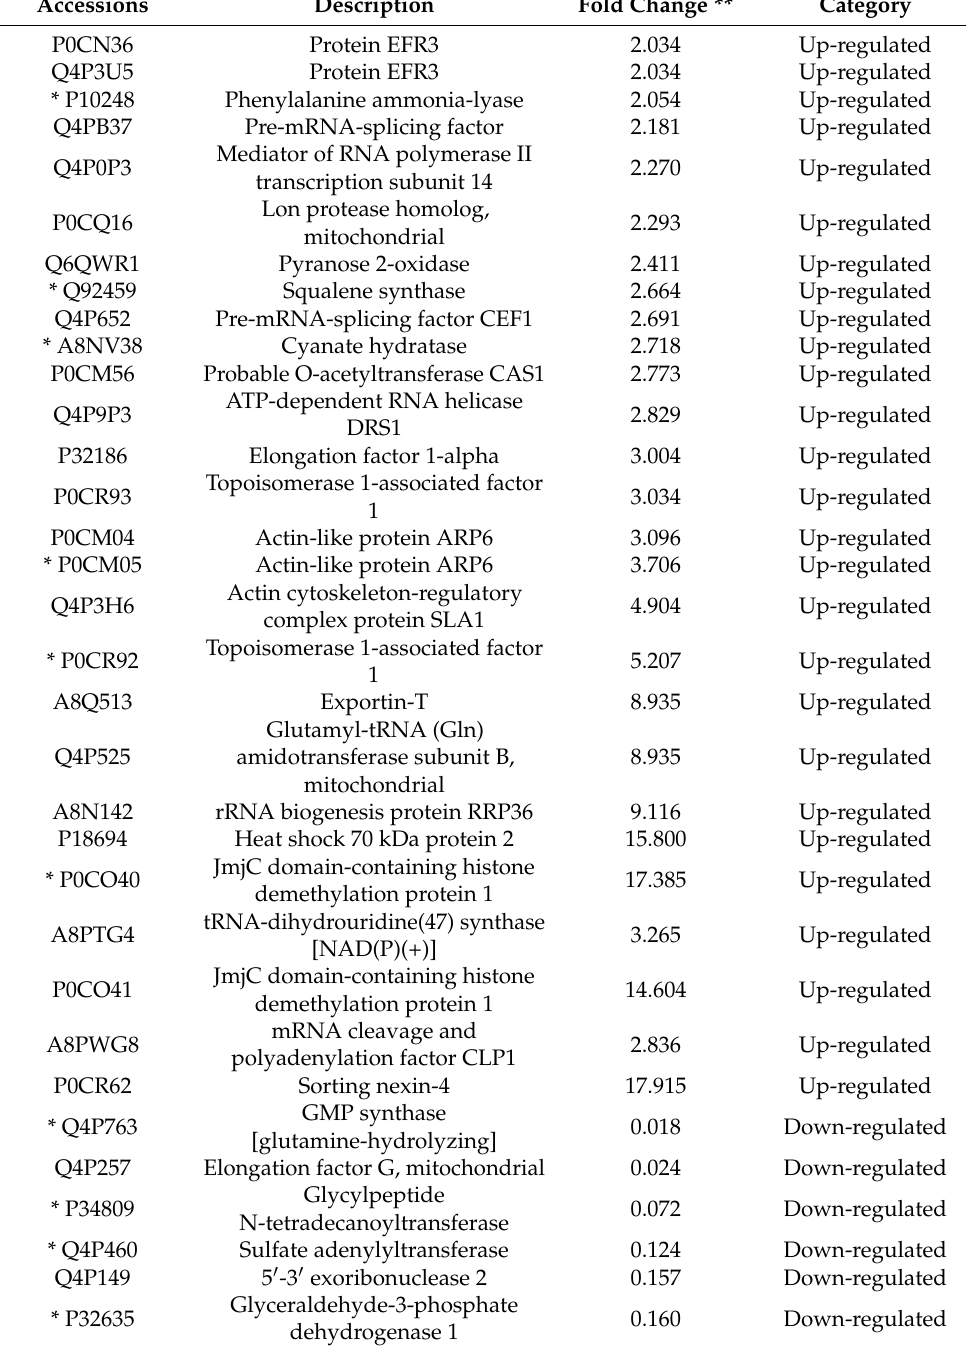
Table 2. List of differentially expressed proteins among virulent (RS15) and less virulent (RS22)